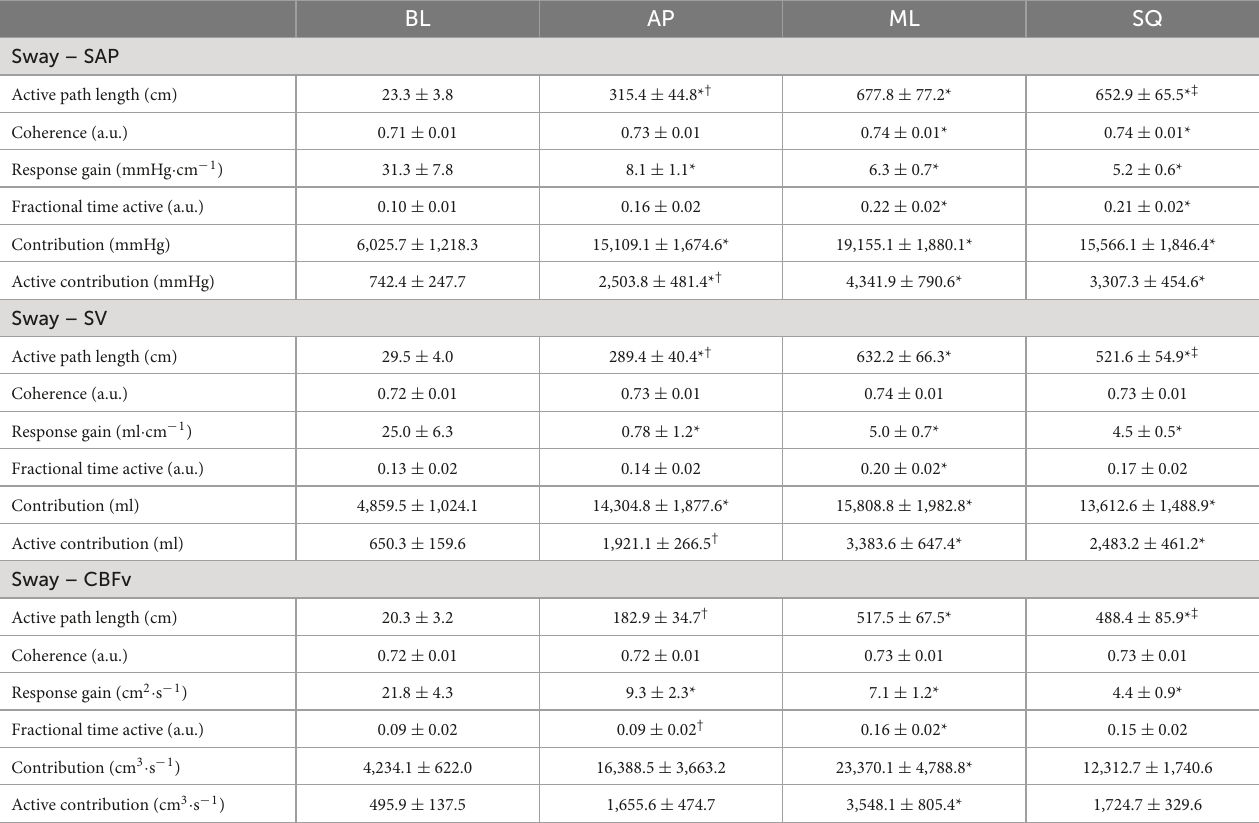
TABLE 3 Wavelet analysis of sway and cardiovascular